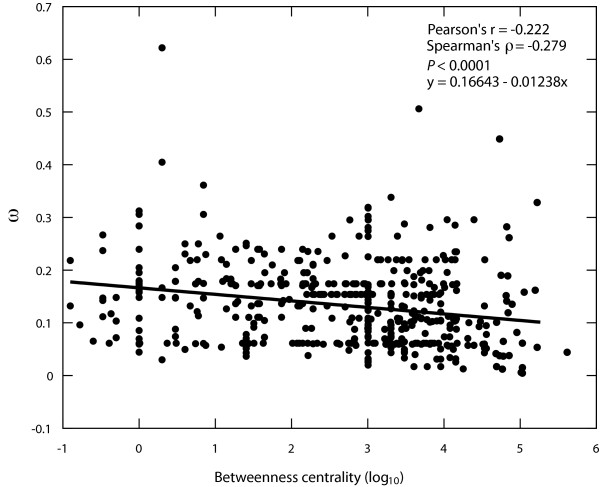
A negative association of betweenness centrality and selective constraint. The log10 transformed betweenness centrality for each reaction (x-axis) is plotted against the estimated selective constraint (ω) for its associated genes. The correlation between these two variables is negative and weak (Pearson's r = -0.222, Spearman's r = -0.279), but highly significant (P < 10-4).